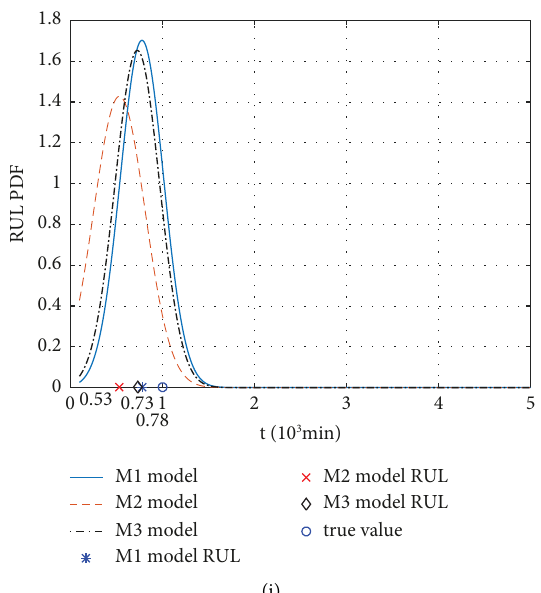
Figure 5: Comparison of RUL between the M1 model, M2 model, and M3 model at diferent times. (a) t RUL estimation. (c) t k � 4 RUL estimation. (d) t k � 6 RUL estimation. (e) t k � 7 RUL estimation. (f) t k � 8 RUL estimation. (g) t k � 9 RUL estimation. (h) t k � 10 RUL estimation. (i) t k � 11 RUL